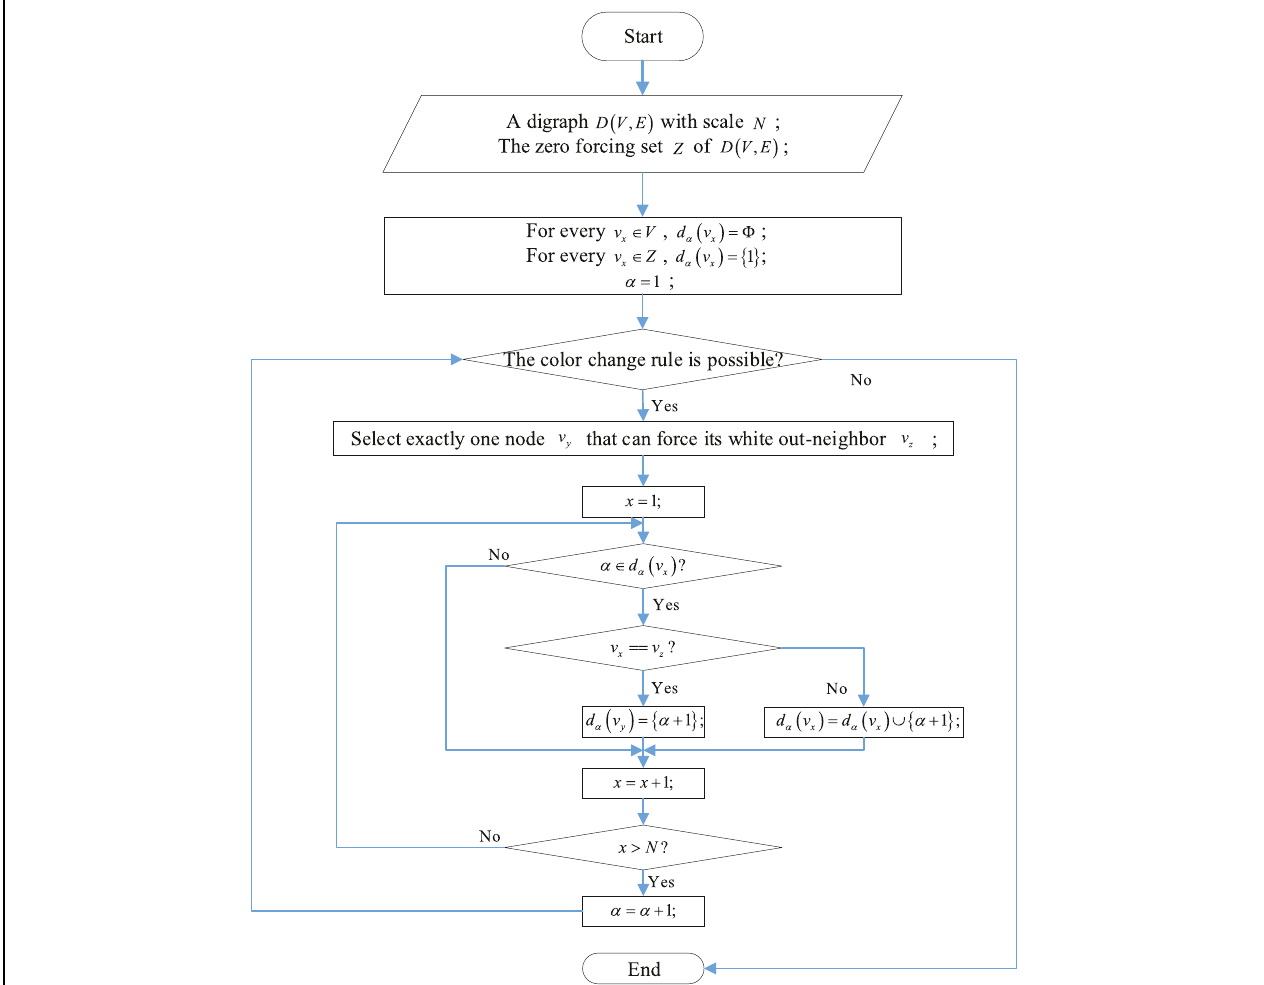
FIGURE 3 | The flowchart of distribution